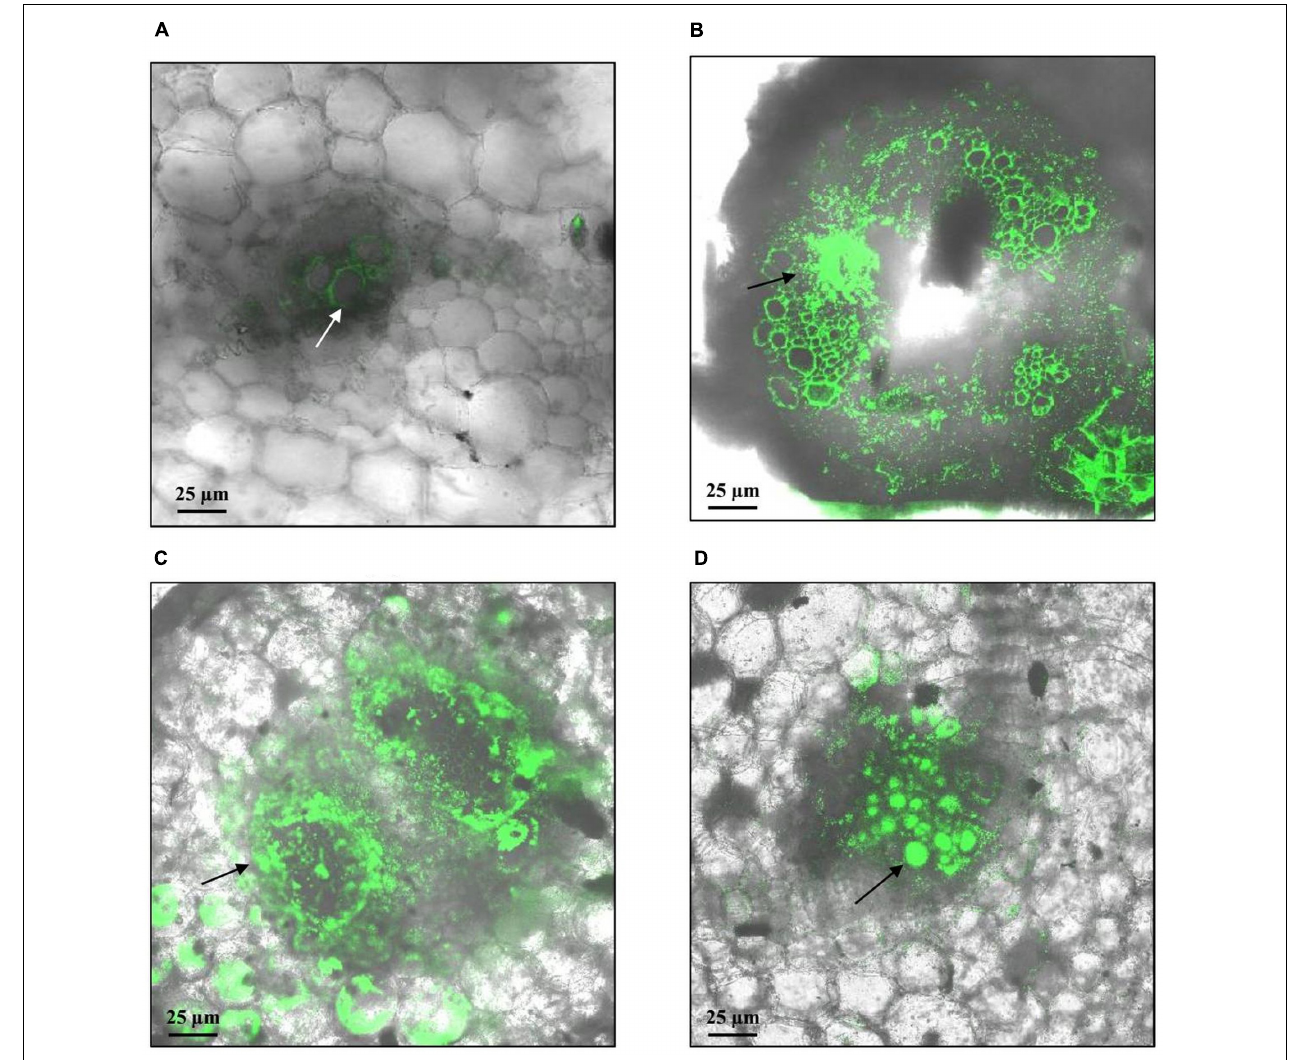
FIGURE 4 | Representative confocal fluorescence micrographs of stem cross-sections of potato plants soil inoculated with R. solanacearum strain UY031 Pps-GFP. Bacterial colonization was evaluated 7 days after inoculation, in the susceptible potato cultivar S. tuberosum cv. Chieftain and interspecific potato breeding lines with different levels of bacterial wilt resistance including susceptible (13001.79) and tolerant (11201.27) clones. (A) Mock inoculated Chieftain plant. (B) Chieftain plant inoculated with R. solanacearum . (C) 13001.79 plant inoculated with R. solanacearum . (D) 11201.27 plant inoculated with R. solanacearum . Dark arrows show bacterial colonization and white arrow shows autofluorescence of xylem